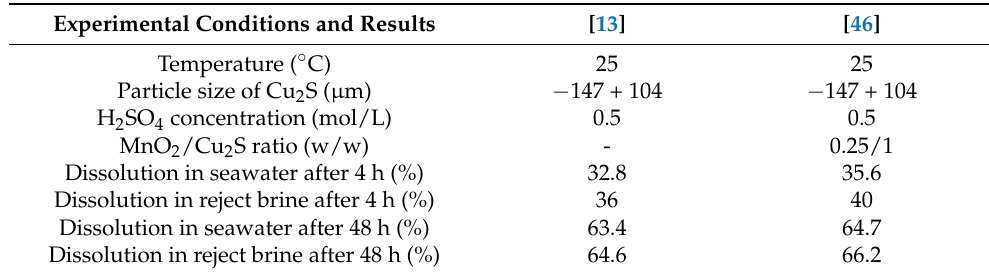
Table 4. Comparison between studies for the dissolution of chalcocite in chloride media, with and without the addition of MnO 2